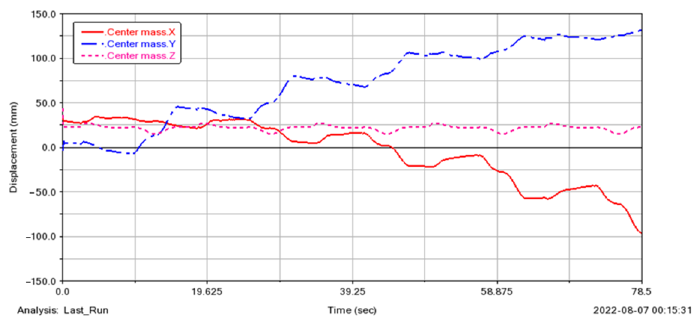
Figure 15. Center of mass trajectory for turning gait.